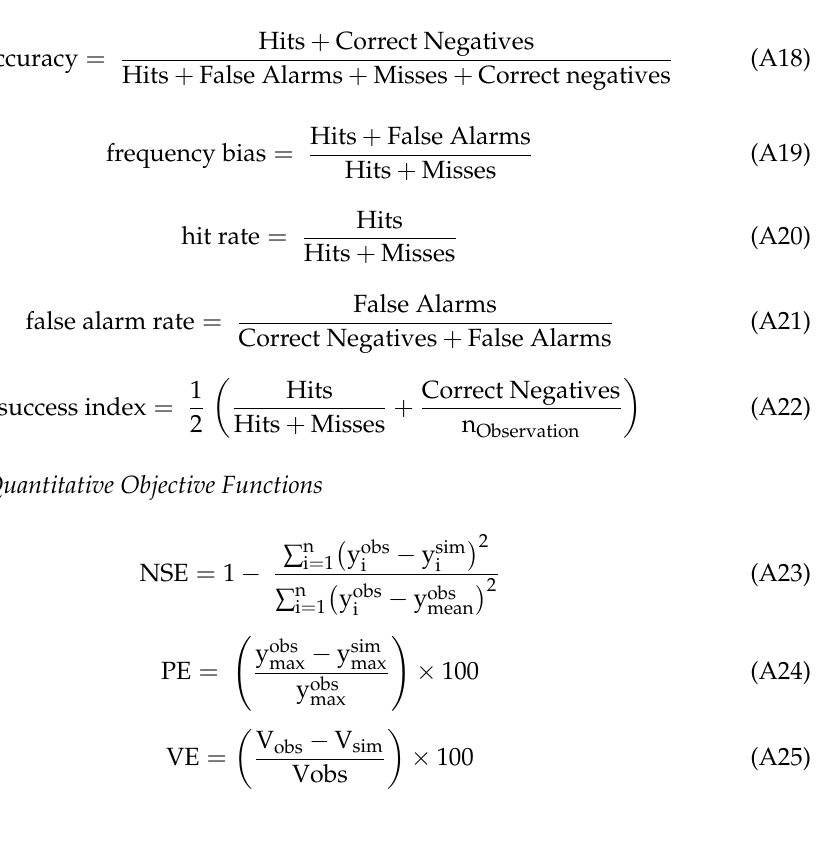
Figure A2. Definition of the contingency table values (Hits, False Alarms, Misses, Correct Negatives) as qualitative comparison between modelled and observed flooded areas